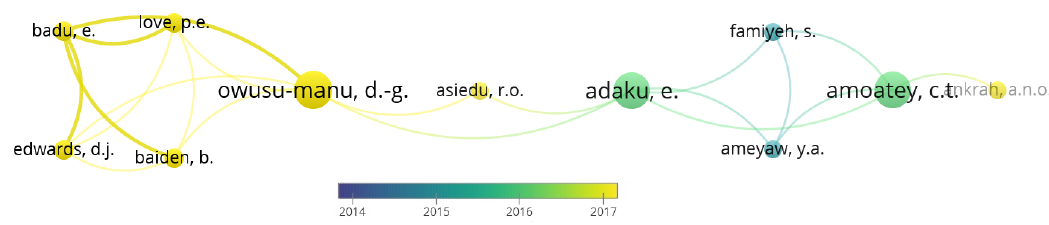
Figure 2. Visualisation of co-authorship network for all 259 co-authors using the full counting method based on the delay effects and causes (DEC) dataset including 94 papers.